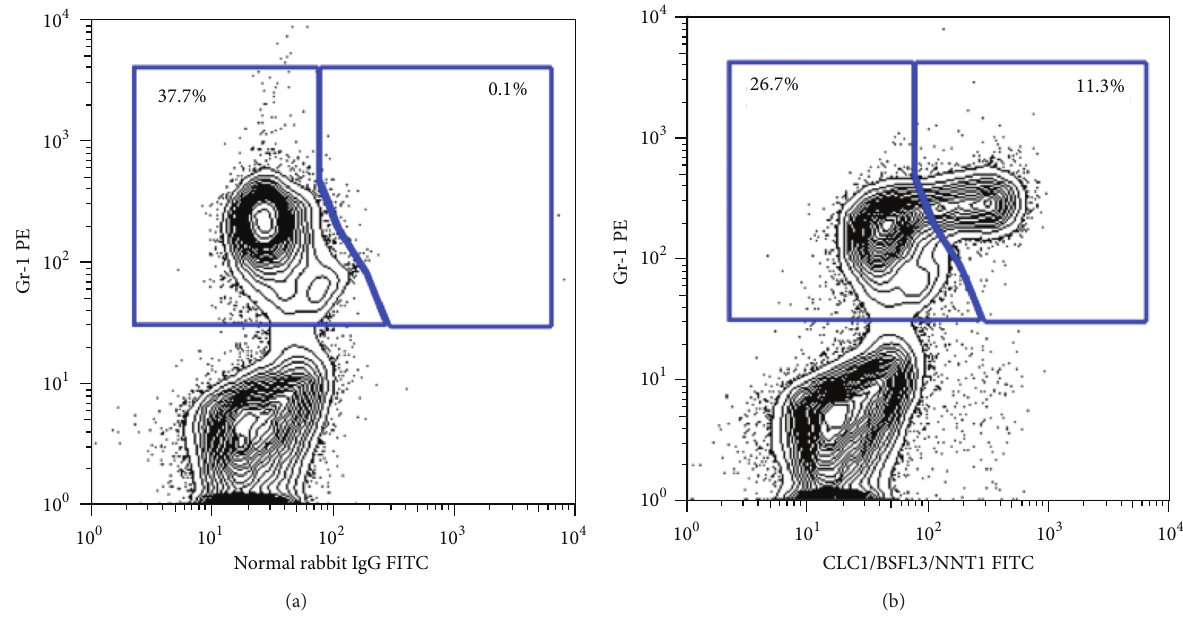
Figure 1: (a) Expression of CLCF-1 in bone marrow of FVB mouse. Cells were isolated from bone marrow (BM) and subjected to flow cytometry. Approximately 11% of BM cells stained with anti-CLCF-1. These cells were also positive for the myeloid differentiation antigen GR-1 but did not express markers for B or T lymphocytes (see text). A representative experiment is